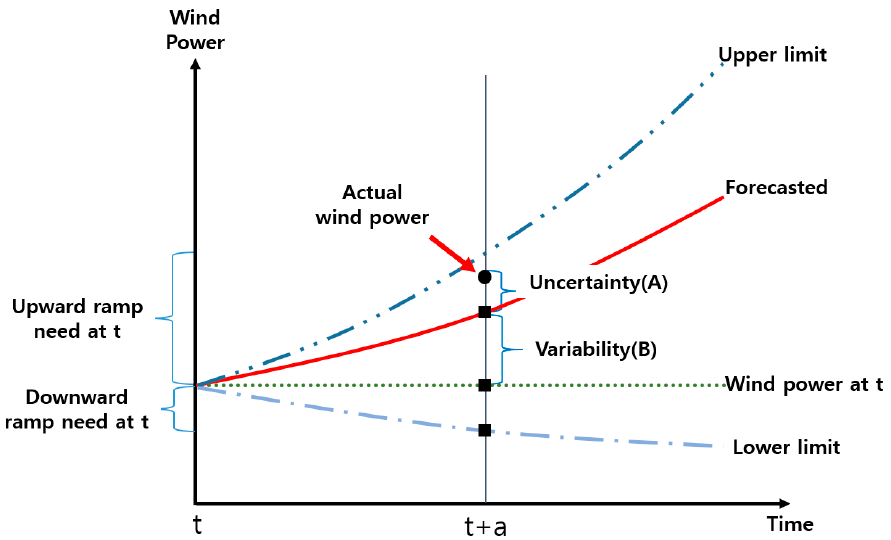
Figure 2. The uncertainty and the variability of wind power.